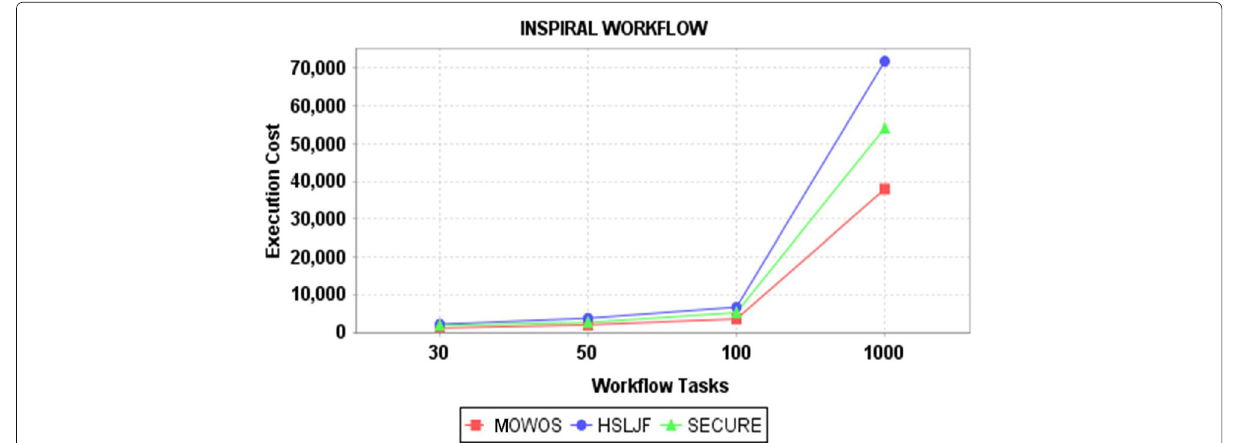
Fig. 8 Comparison of execution cost using inspiral